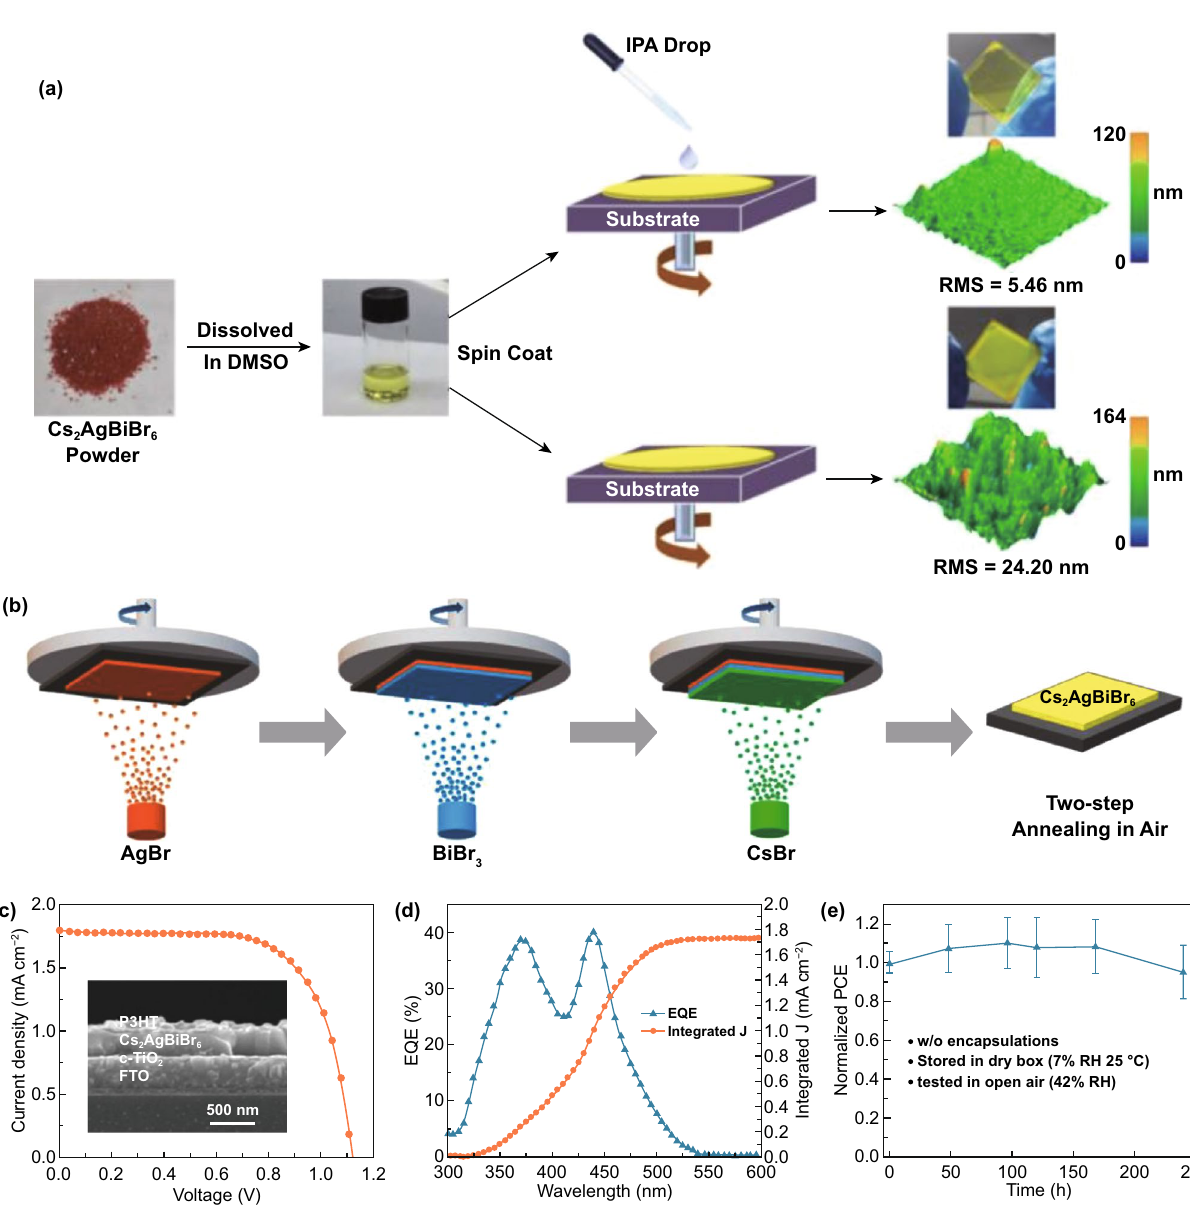
Fig. 16 a Schematic illustration of the spin coating process of Cs 2 AgBiBr 4 with and without antisolvent dropping program, and the morphology of the as-prepared film. Reproduced with permission from Ref. [189] b Scheme of sequential vapor deposition process. c J – V curve of the opti- mized solar cell. Inset: Cross-sectional SEM image of the device. d EQE spectrum and the integrated current density with AM 1.5G photon flux. e Evaluation of long-term stability of the solar cells stored in dry box. Reproduced with permission from Ref.